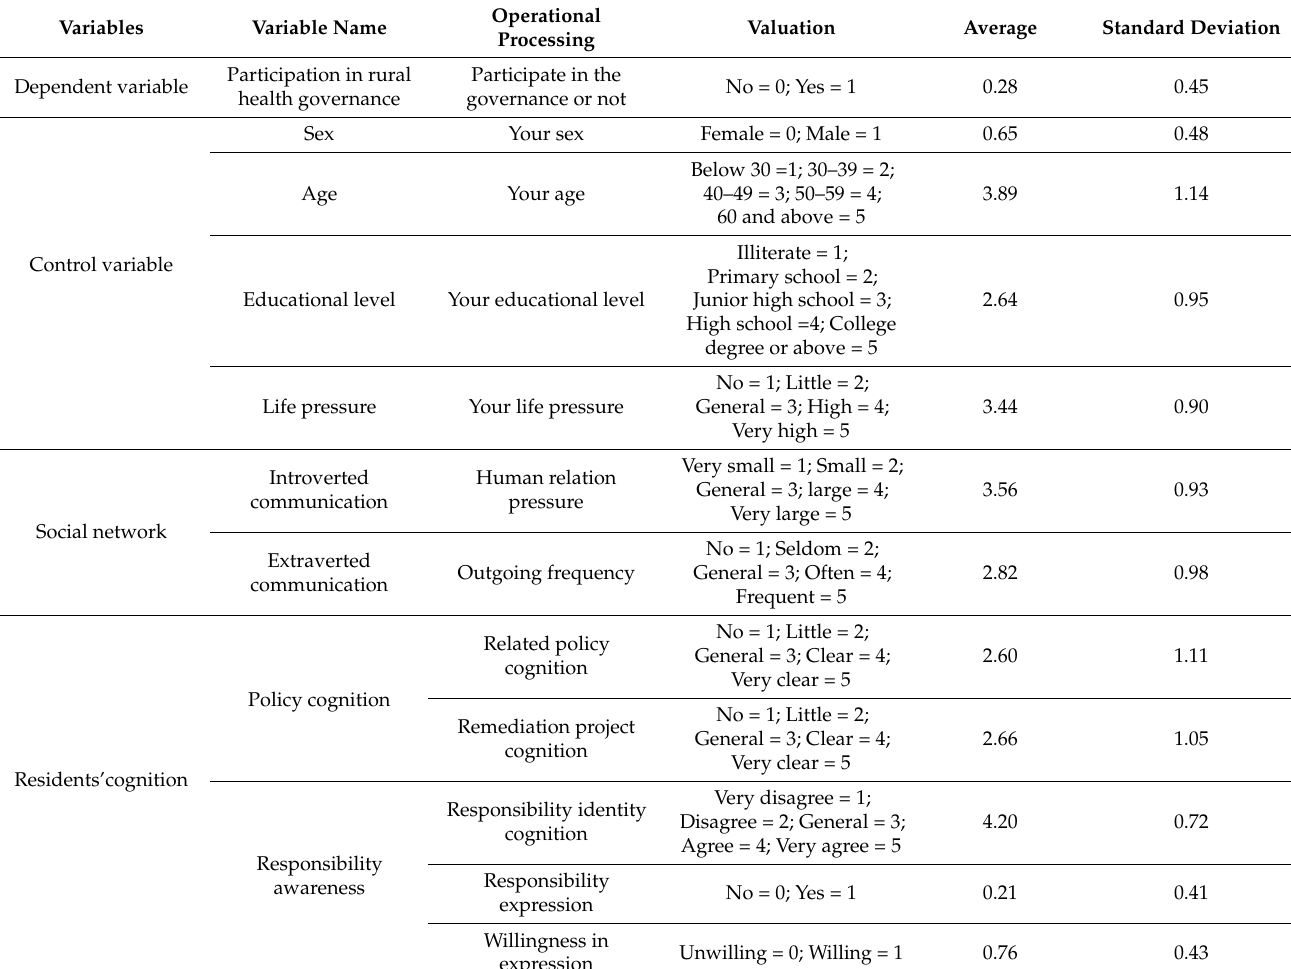
Table 2. Variable definitions and